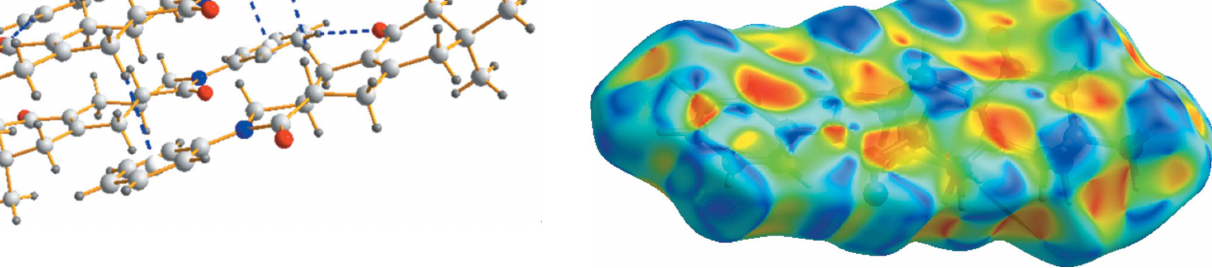
Figure 4 The Hirshfeld surface mapped over